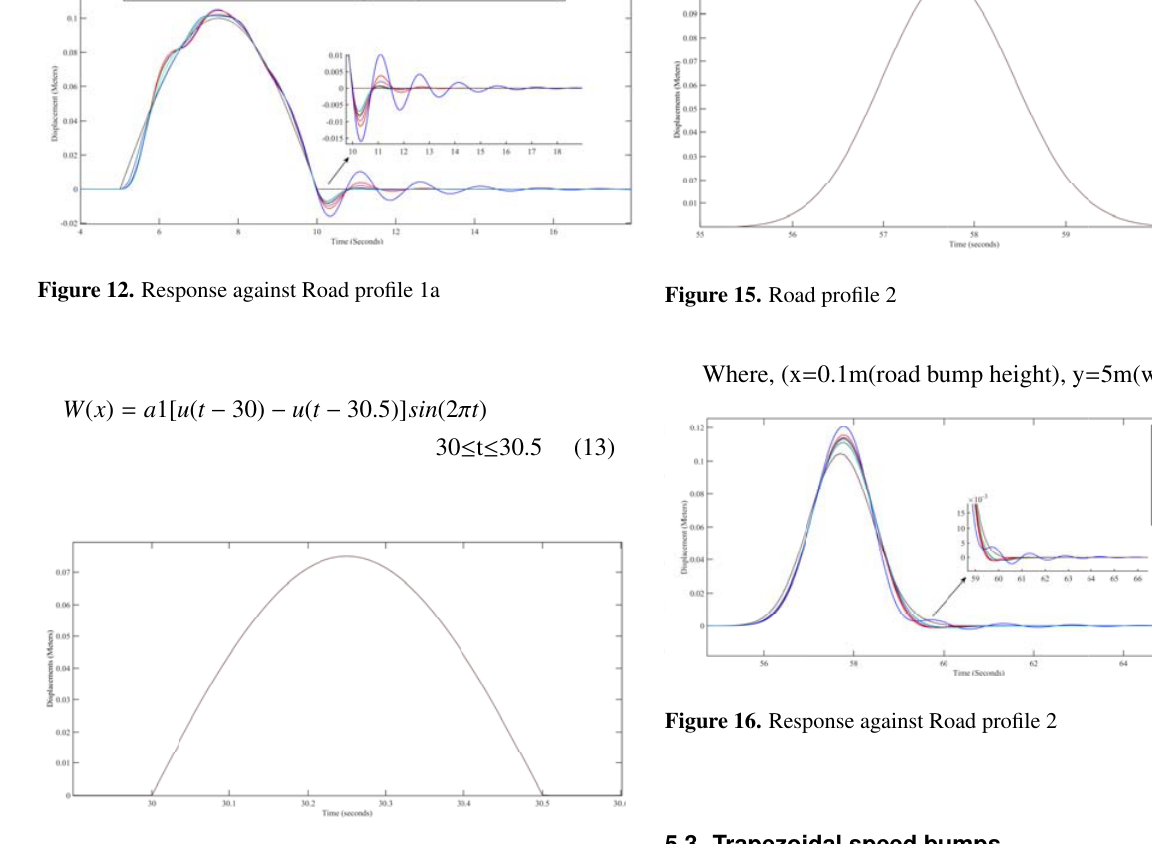
Figure 13. Road profile 1b